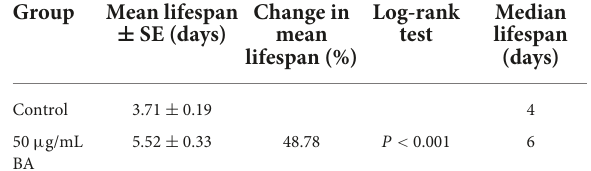
TABLE 4 Effects of betulinic acid (BA) on juglone-induced oxidative stress. Group